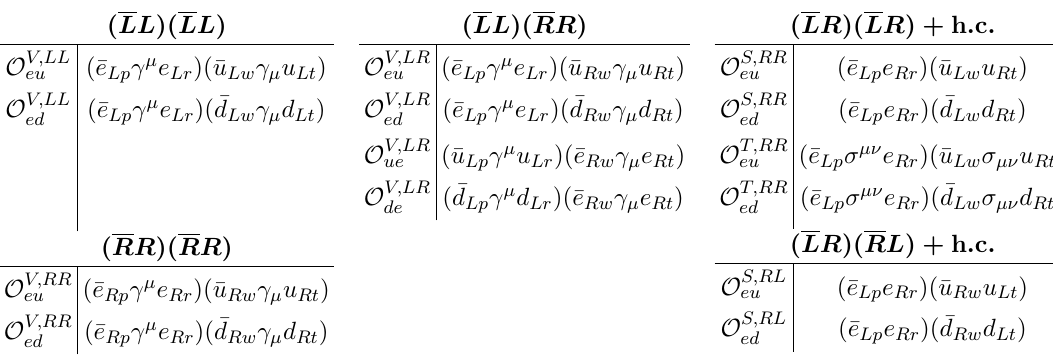
Table 1 . Semileptonic LEFT operators involving a charged-lepton bilinear and a quark